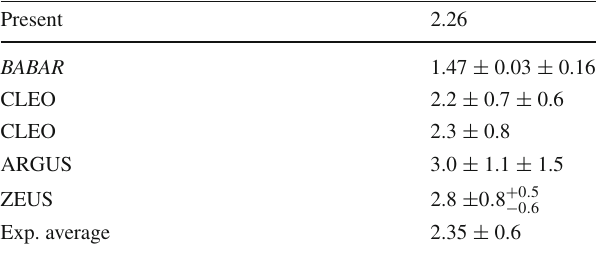
Table 9 The values of ratio ments and from present